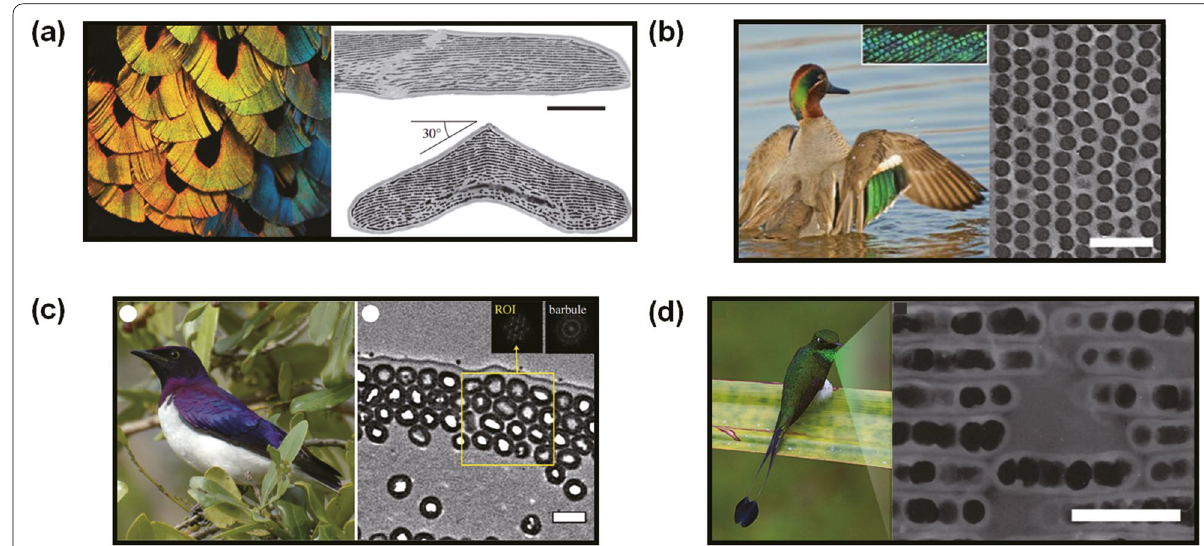
Fig. 5 Melanin as a main structural component of structural coloration. ( a ) Multilayer thin films composed of melanosomes in the male Lawes’ parotia’s breast feathers. (Scale bar: 5 μm). Reproduced with permission (Stavenga et al. 2011). Copyright 2011, The Royal Society. ( b ) Non‑close packed melanosomes in the wing feathers of the green‑winged teal. (Scale bar: 500 nm). Reproduced under the terms of CC BY license (Xiao et al. 2017). Copyright 2017, The Authors. Published by The American Association for the Advancement of Science. ( c ) Close packed hollow melanosomes in the feather barbules of the violet‑backed starling. (Scale bar: 500 nm). Reproduced with permission (Eliason et al. 2013). Copyright 2013, The Authors. Published by The Royal Society. ( d ) Layered hollow platelet‑shaped melanosomes in the gorget feathers of the white‑booted racket‑tail hummingbird. (Scale bar: 500 nm). Reproduced with permission (Eliason et al. 2020). Copyright 2020,